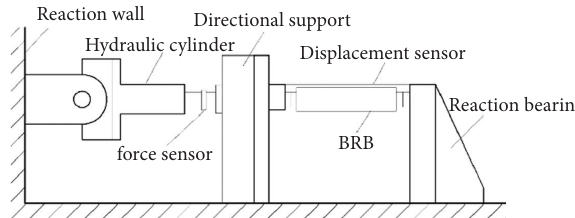
Figure 4: Schematic diagram of test principle.